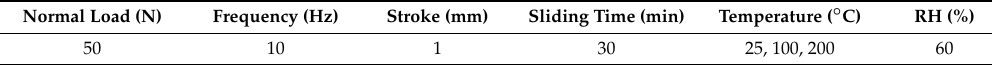
Figure 2. Schematic diagram of the ball-on-disk tribometer. Table 1. Friction and wear test conditions.